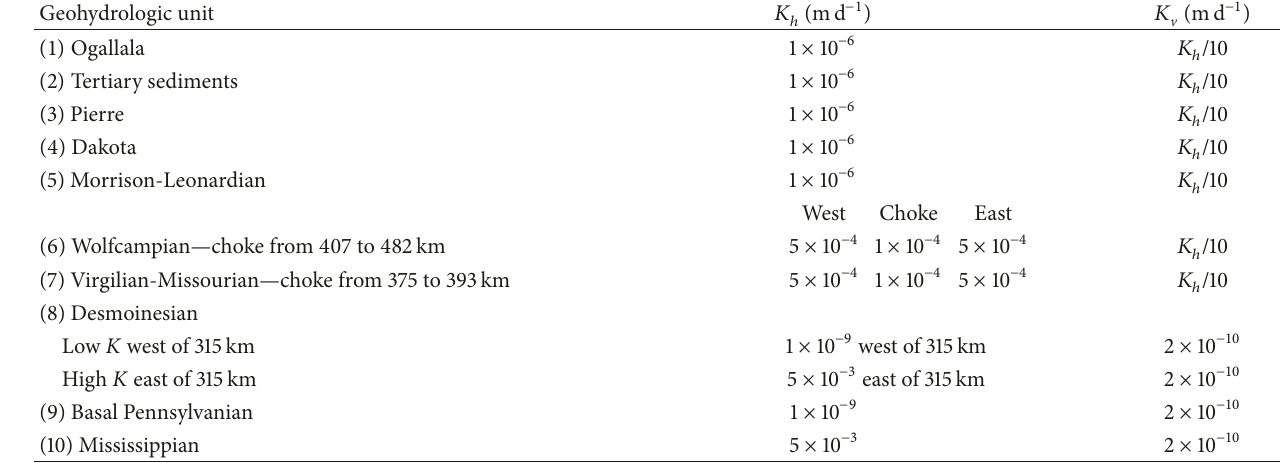
Table 5: Hydraulic conductivities of the (10) geohydrologic units (layers) of each model in the sequence. Hydraulic conductivities in meters per day (md −1 ). In units (1)–(7), the vertical hydraulic conductivity 𝐾 is set to one-tenth the value of the horizontal hydraulic conductivity V 𝐾 𝐾 choke separates more permeable units in the west and east. In unit (8), 𝐾 is higher in the east than in the ℎ . In units (6) and (7), a low-